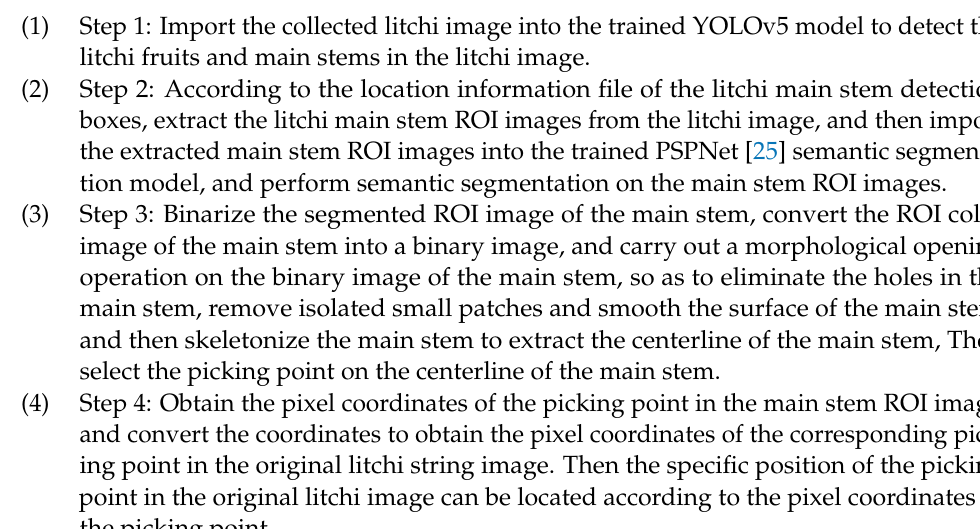
Figure 1. The proposed flow chart for identifying picking